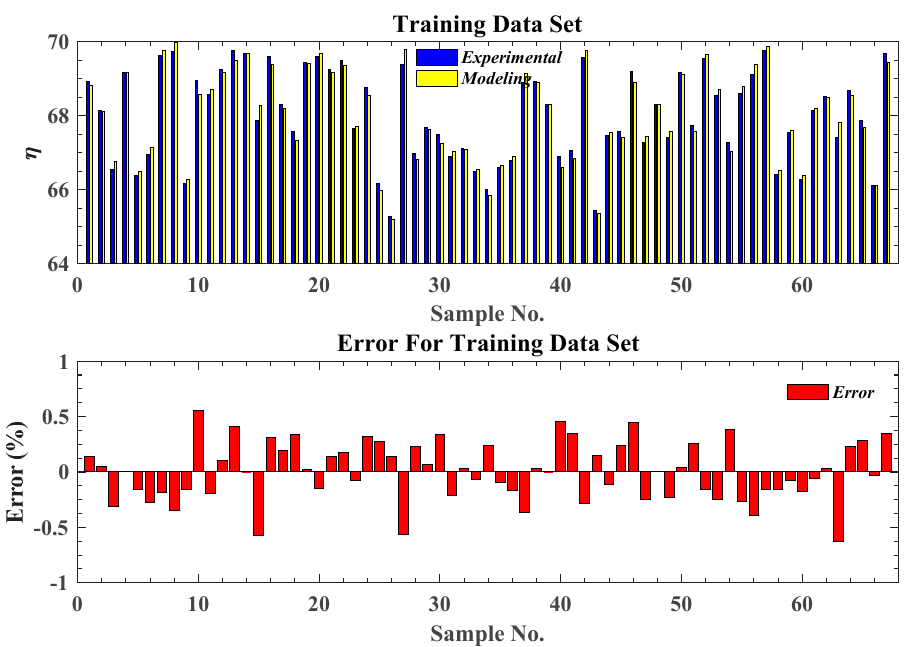
Figure 6. Comparison of experimental data and modeling for training stage (75 data).